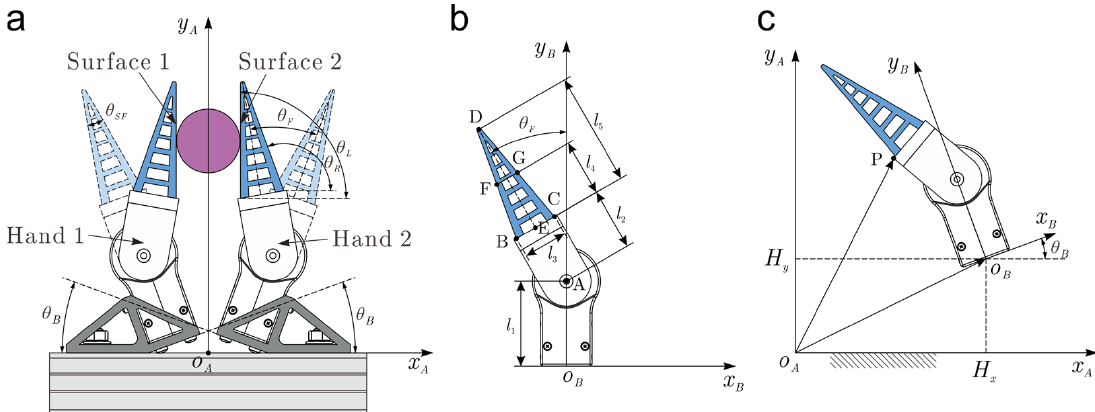
Figure 3. Kinematic model of the modular hand. ( a ) Absolute coordinate system of the demonstrated double-hand robotic end-e ff ector, ( b ) Relative coordinate system of the modular hand, ( c ) Displacement description of the hand in the absolute coordinate system.